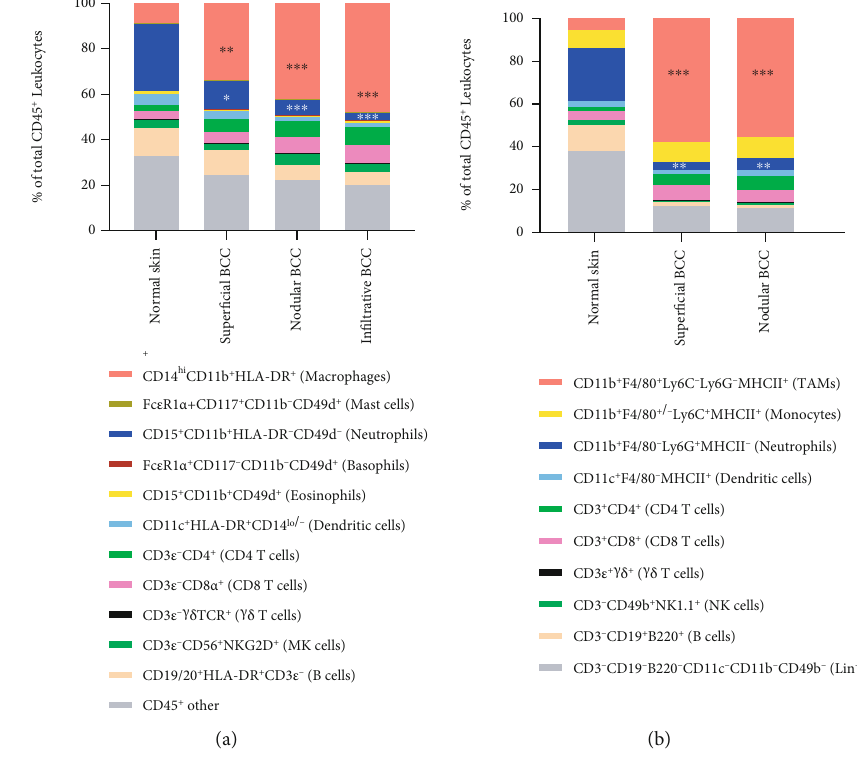
Figure 4: High macrophage density and lower neutrophil density in human BCC skin and a syngeneic mouse model of BCC. (a) In human samples, FACS analysis of leukocytes as a % of total CD45 + cells in normal skin, the various grade of BCC. ∗∗ P < 0 : 01 compared to normal skin, ∗∗∗ P < 0 : 001 compared to normal skin by Mann – Whitney test. (b) In a syngeneic mouse model of BCC, FACS analysis of leukocytes as a % of total CD45 + cells in normal skin, various grade of BCC. ∗∗ P < 0 : 01 compared to normal skin, ∗∗∗ P < 0 : 001 compared to normal skin by Mann – Whitney